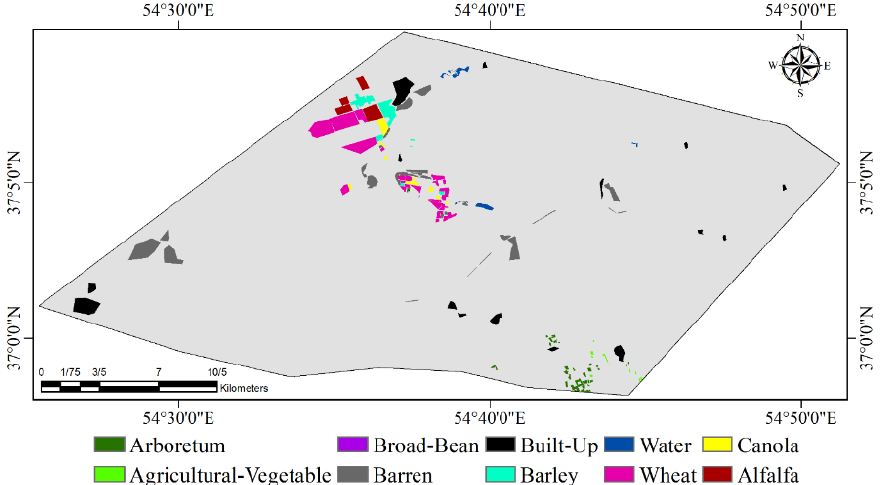
Figure 2. The distribution of the reference samples from ten classes collected over the study areas. As is clear from Figure 2, more arboretum and agricultural-vegetable areas are located on the right side of the study area while other crops are dispersed over the study area. Table 2 provides the number of samples for each class. The wheat and broad bean classes had the maximum and minimum numbers of reference samples. There are different approaches, such as manual splitting, random splitting, and non-random splitting for the division of reference samples into training, validation, and test samples [64]. In this regard,